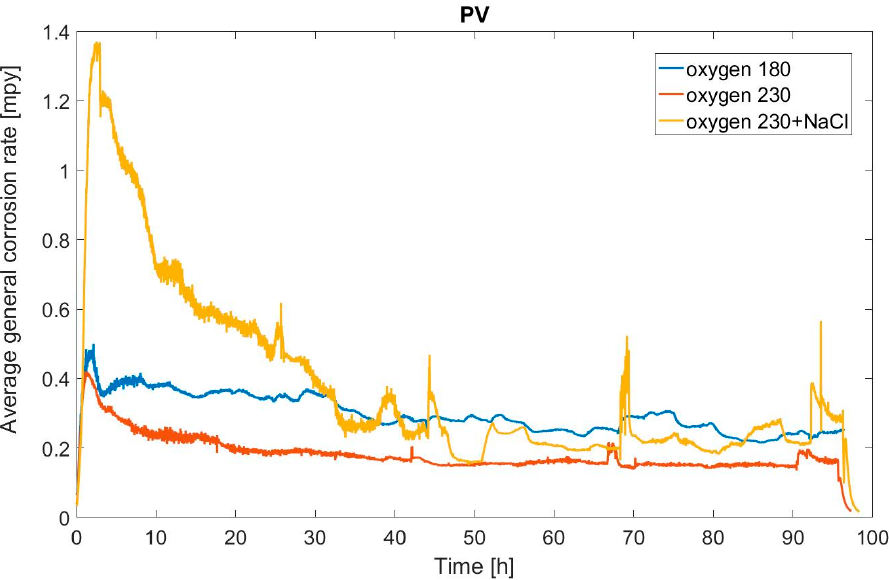
Figure 3. General corrosion rate measured in sulfolane solutions with the addition of oxygen at 180 and 230 °C and oxygen with NaCl at 230